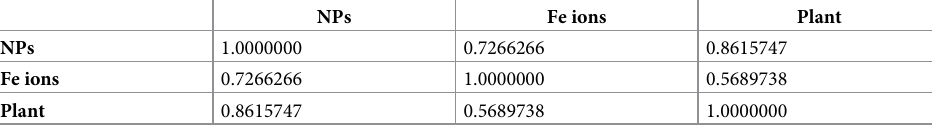
Table 2. The table output displays the correlation results between NPs, Fe ions and plant. NPs Fe ions Plant NPs 1.0000000 Plant 0.8615747 1.0000000 The p-value of the test is 0.02659 which is less than the significance level alpha = 0.05. We can conclude that NPs and Fe ions are significantly correlated with a correlation coefficient of 0.7266266 and p-value of 0.02659. The p-value of the test is 0.00283 which is less than the significance level alpha = 0.05. We can conclude that NPs and plant are significantly correlated with a correlation coefficient of 0.8615747 and p-value of 0.00283. The p-value of the test is 0.1099 which is greater than the significance level alpha = 0.05. We can conclude that Fe ions, and Plant are not significantly correlated with a correlation coefficient of 0.5689738 and p-value of 0.1099.